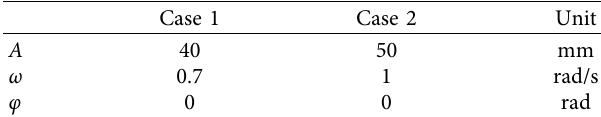
Figure 4: Bump in the road. Table 2: Parameter of the condition from the road